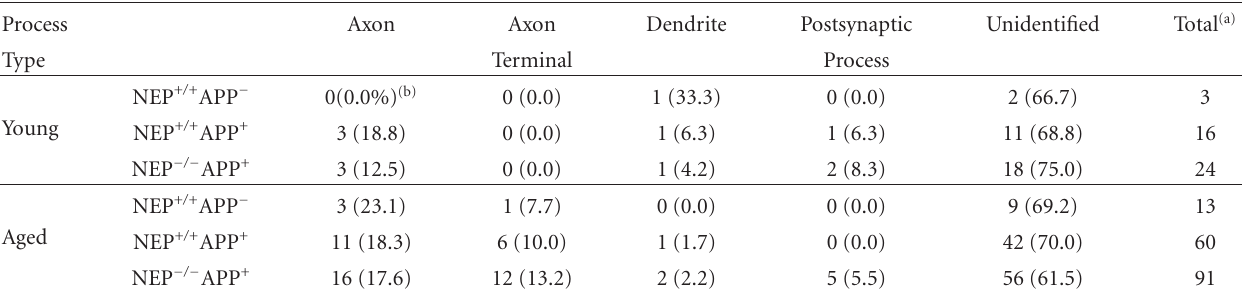
Table 1: Distribution of anti-annular protofibril immunoreactions ( α APF-IRs) localized to cell processes. Process Axon Axon Dendrite Postsynaptic Unidentified Total (a)